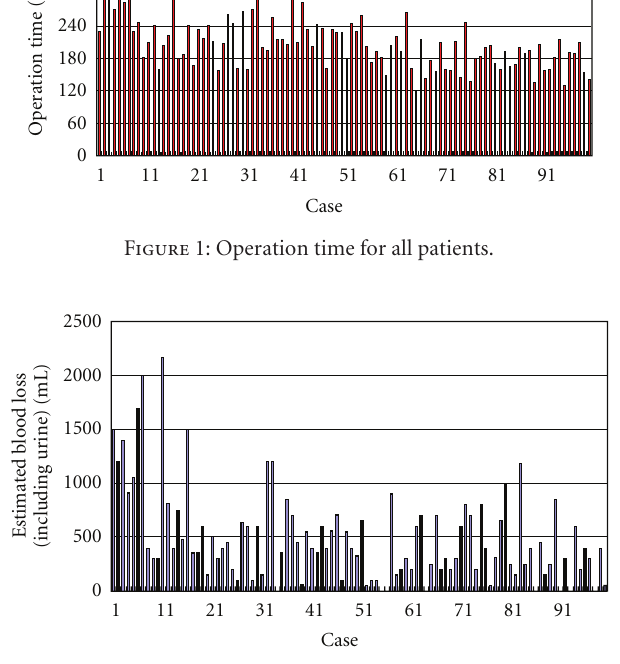
Figure 2: Estimated blood loss (including urine) for all patients.